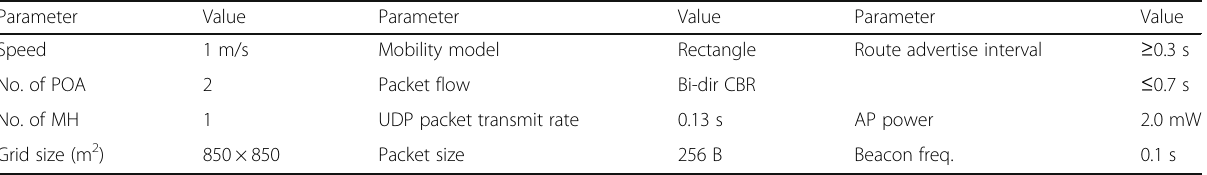
Table 1 Simulation parameters under which MHP and DMHP are examined Parameter Value Parameter Value Parameter Mobility model Rectangle